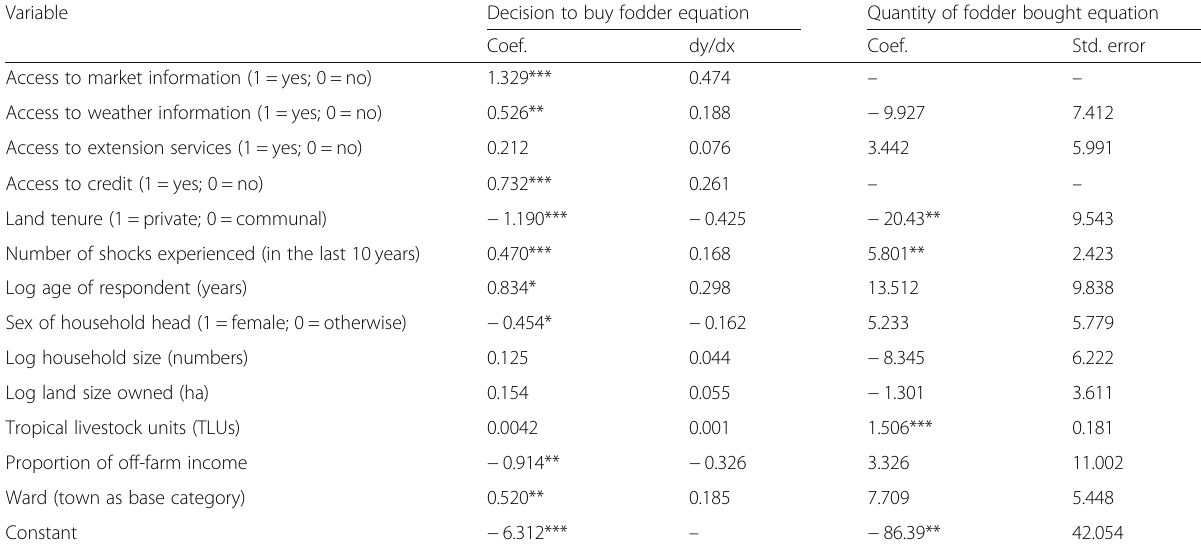
Table 4 Two-step Heckman model results for fodder market participation Variable Decision to buy fodder equation Quantity of fodder bought equation